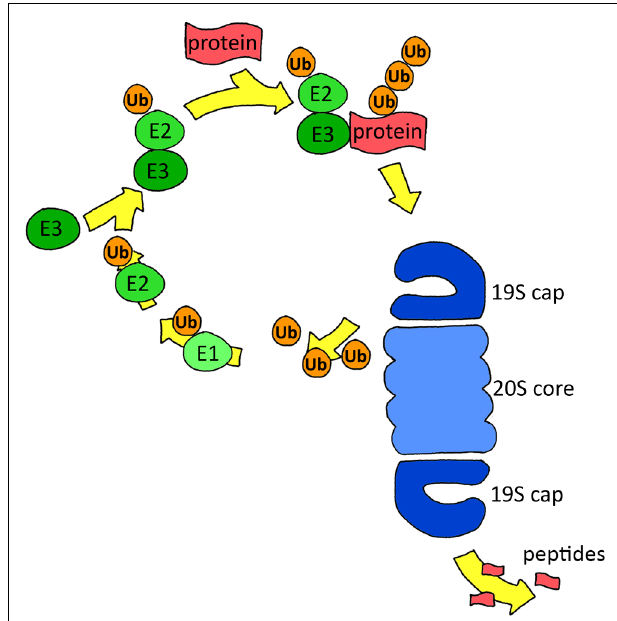
FIGURE 1 | Scheme of the ubiquitin proteasome system. Proteins are targeted for degradation by ubiquitination via E1, E2, and E3 enzymes.The proteasome recognizes and removes the ubiquitination signal, unfolds the protein and finally degrades it.